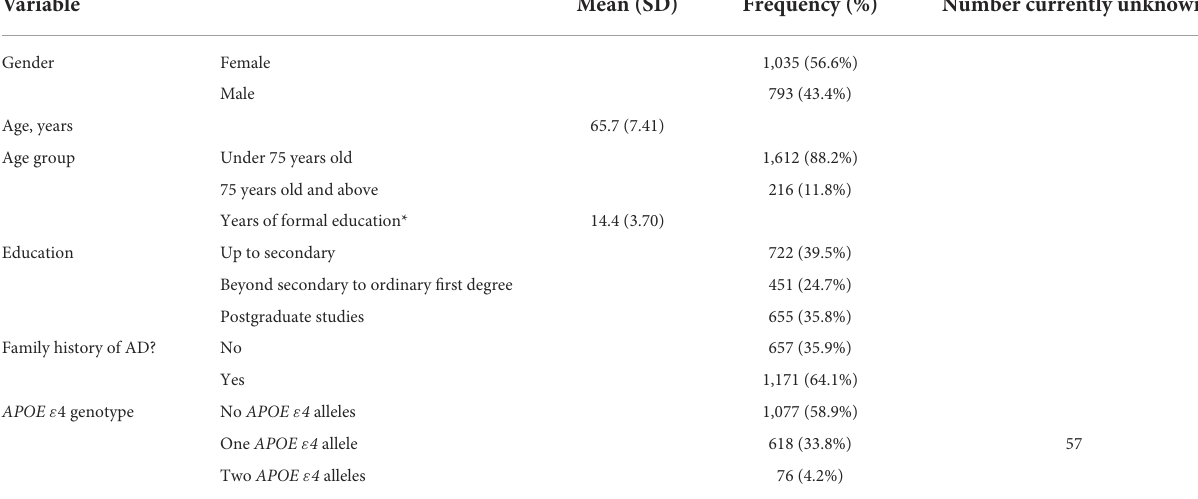
TABLE 1 Baseline characteristics of 1,843 non-screen failed participants in the EPAD LCS (8).